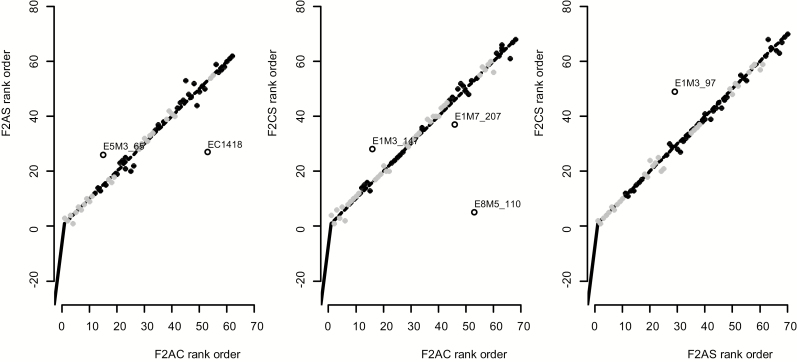
Paired comparisons of marker order between the F2AC, F2AS and F2CS genetic maps. Points indicate the relative map order of genetic markers common to each pair of compared genetic maps. Blocks of alternating light grey and black points indicate different LGs. Labelled circles indicate genetic markers in discrepant map positions (≥10 difference in relative map order) in each pair of compared genetic maps. The dashed lines indicate identical marker order for comparison. Summaries of Kendall’s rank correlation tests are shown in the top left corner of each panel.